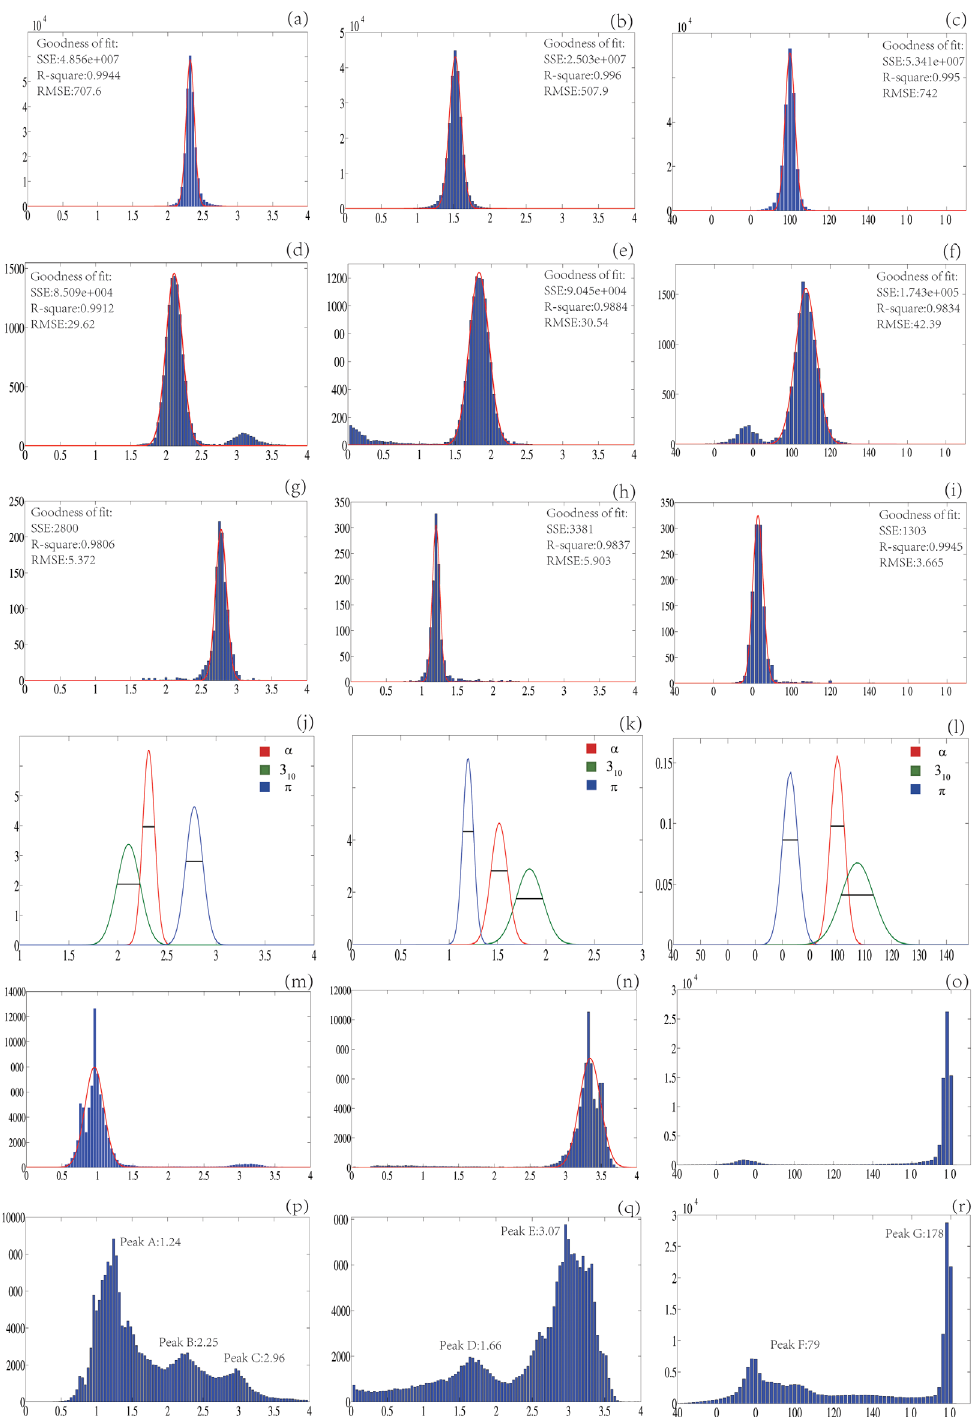
Fig 1. The r , p , t statistics for five different groups (H, G, I, E, R). The five triples of figures ( a , b , c ), ( d , e , f ), ( g , h , i ), ( m , n , o ) and ( p , q , r ) are respectively the r , p , t distributions for α -helix (H), π -helix(G), 3 10 -helix (I), β -sheet (E) and the other (R) groups. Except for figures j , k and l whose y-axes are the scale for a normal distribution, the y-axes in all the other figures are the number of residues. For each row, the x-axis is respectively the radius ( r in Å ), pitch ( p in Å ) and turn angle ( t in degree). There is a small peak in figures d , e , f from the left-handed helices. Figures j , k and l display the fitted r , p , t normal distribution curves for the three helix types where each line segment has a length of 2.0 σ where σ is the standard deviation. All the overlaps are well below the 2 σ lines except for t statistics where the overlap between the α -helix normal curve and 3 10 -helix normal curve is slightly above the 2 σ line.